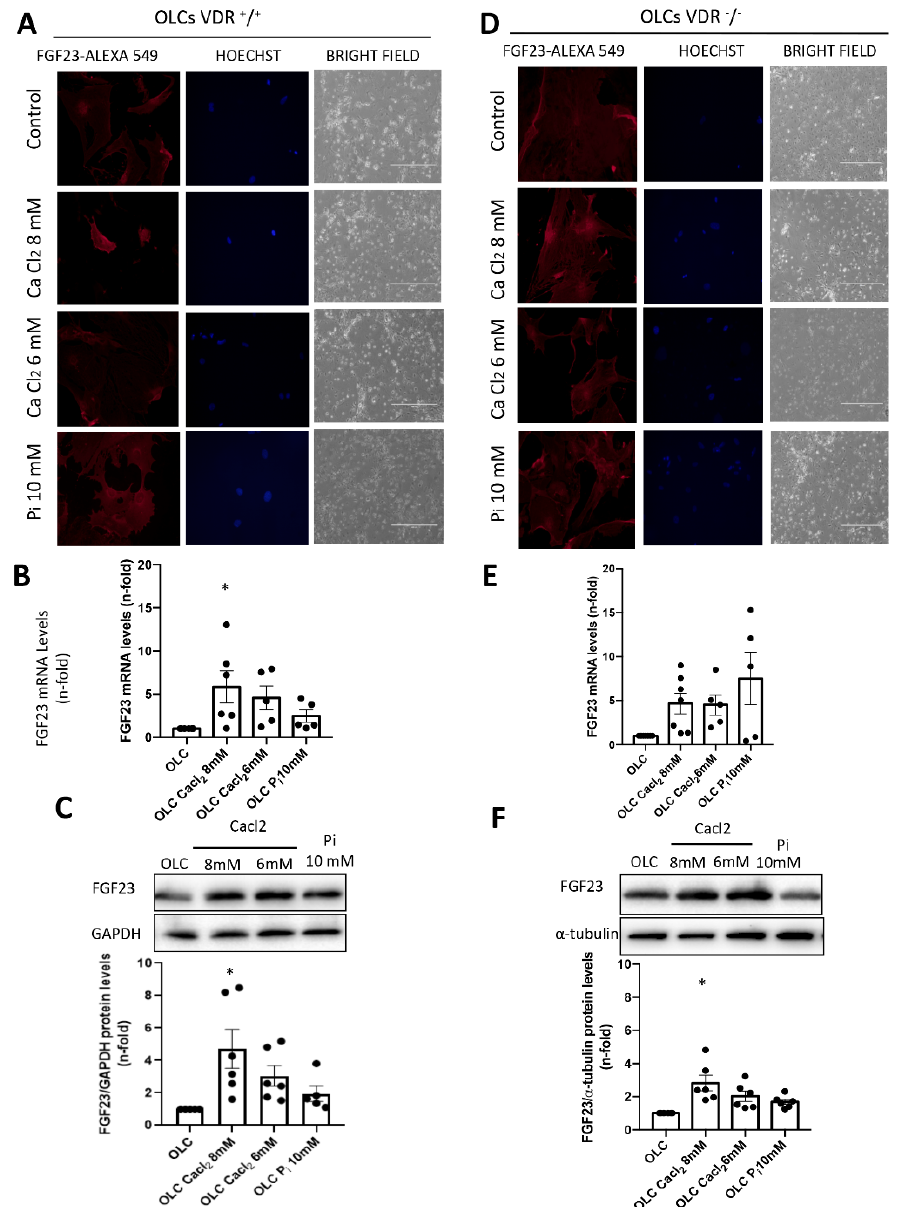
Figure 2. Study of the effects of calcium (CaCl 2 ) and phosphorus (P i ) on the gene and protein expression of FGF23. The OLCs were stimulated with different concentrations of calcium chloride (Cacl 2 ) and inorganic phosphorus (Pi: NaH 2 PO 4 + Na 2 HPO 4 ) for 18 h. ( A , D ) FGF23 expression by fluorescence microscopy in CaCl 2 and P i stimulated VDR +/+ and VDR − / − OLCs. ( B , E ) FGF23 gene expression in CaCl 2 and P i stimulated VDR +/+ and VDR − / − OLCs by RT PCR. ( C , F ) The protein expression of FGF23 was also studied by Western blot. Data are expressed as the mean ± SEM of 4–6 independent experiments, * p < 0.05 vs. OLC without